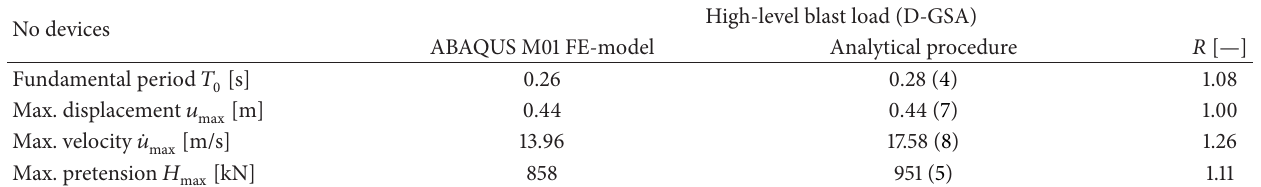
Table 4: Comparison of numerical and analytical results for the fac¸ade-module not equipped by devices.